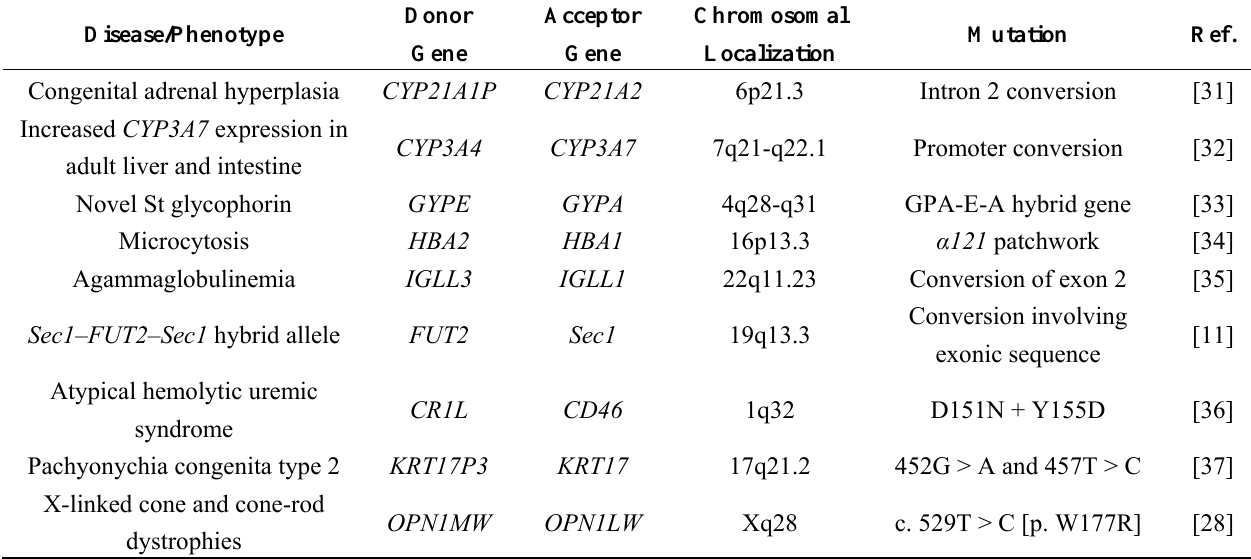
Table 2. Recently collated examples of interlocus gene conversion